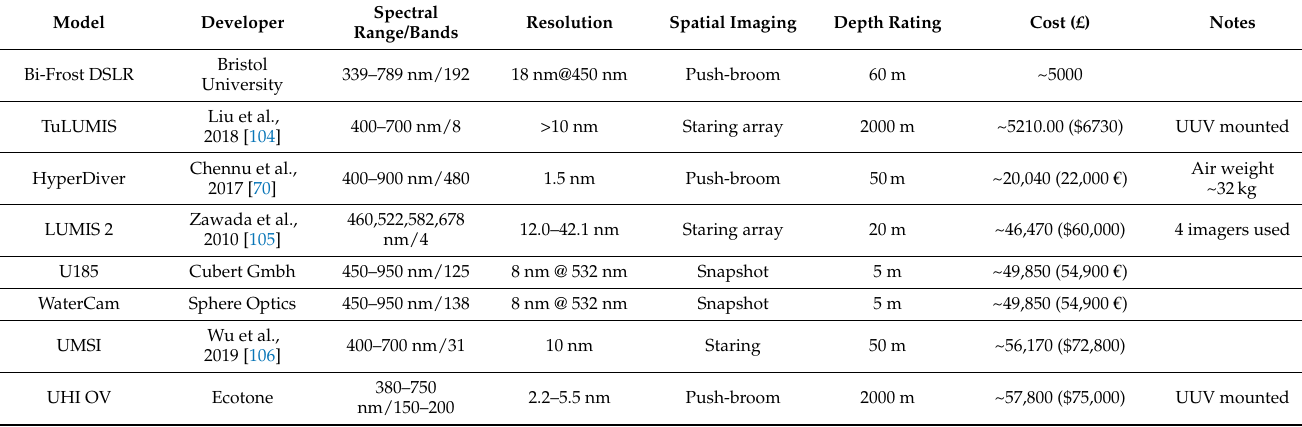
Table 1. A comparison of the selection of underwater spectral imaging systems as outlined by Liu et al., 2020 [69] including the HyRi/HyFi ordered by